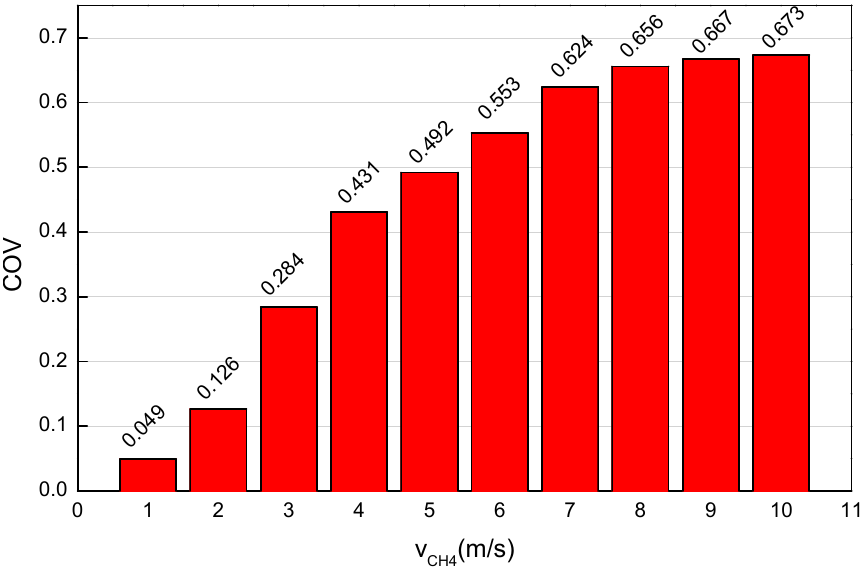
Figure 8. COV at the flow distance of z = 40 D (40th cross section) under different gas flow velocities.